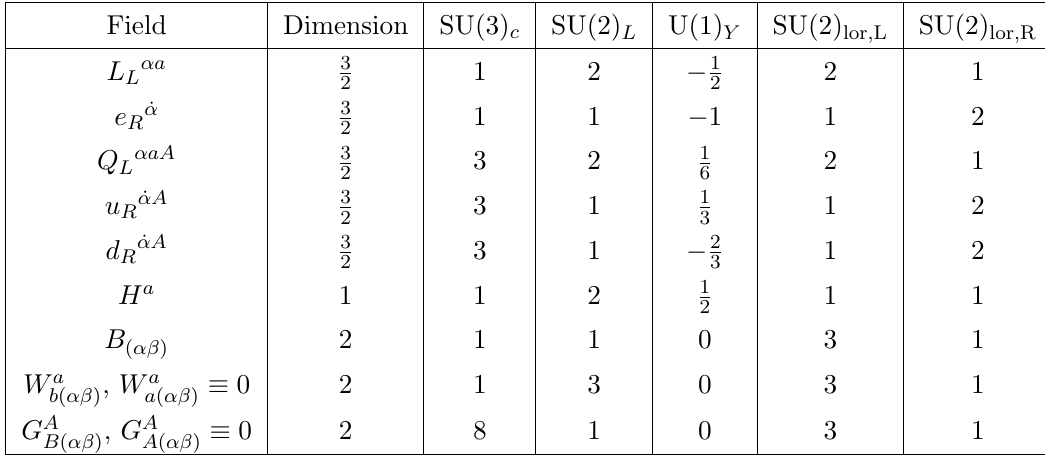
Table 1 . The (cid:12)elds of the one generation Standard Model in component form, along with their mass dimensions, and their representations under the SM